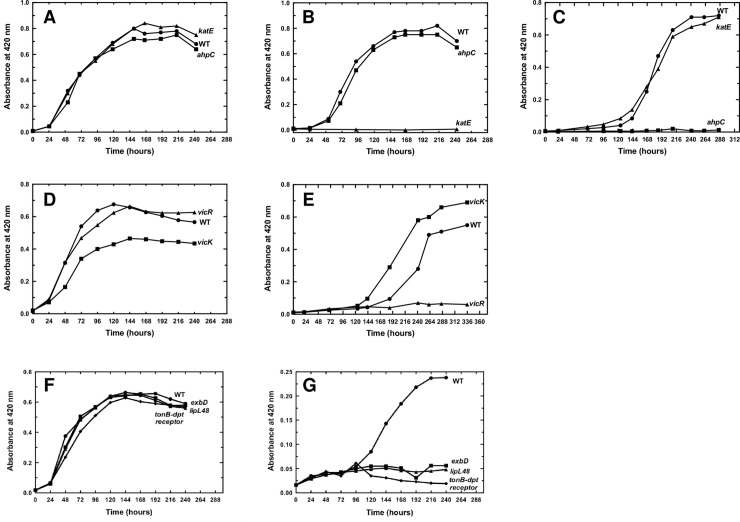
Effect of the inactivation of PerR-controlled genes on Leptospira growth in the presence of ROS.L. interrogans WT, katE (Man69) and ahpC (Man1368), vicK (Man1448) and vicR (Man899), tonB-dpt receptor (Man1022), exbD (Man782), and lipl48 (Man1089) mutant strains were cultivated in EMJH medium (A, D, F) or in the presence of 2 mM H2O2 (B) or of 2 μM paraquat (C, E, G). Growth was assessed by measure of absorbance at 420 nm.